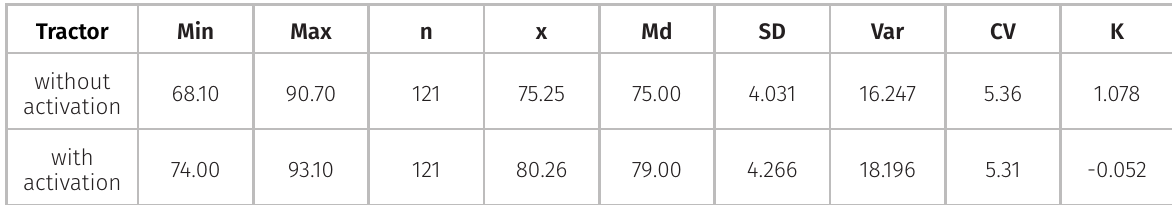
Table I. Descriptive statistics of the noise emitted by a tractor without activation and with activation of a rotary